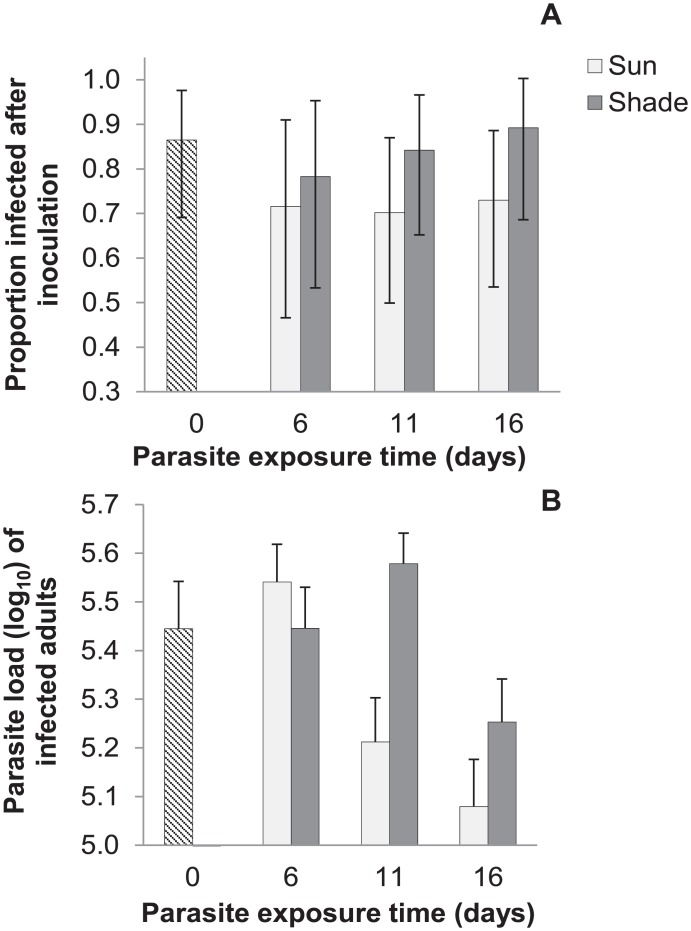
Experimental results on infectivity and pathogen load following spore exposure to sun or shade treatments for 0, 6, 11 or 16 days.(a) Proportion of monarchs infected following inoculation with spores on milkweed leaves exposed for 0 days (n = 27); 6 days, in either sun (n = 15) or shade conditions (n = 15); 11 days in sun (n = 23) or shade (n = 24); or 16 days in sun (n = 25) or shade (n = 19). Error bars show Jeffrey’s 95% confidence intervals for binary data. (b) Pathogen load (log-transformed) of monarchs infected with spores exposed for 0 days (n = 22); 6 days, in either sun (n = 10) or shade conditions (n = 11); 11 days in sun (n = 14) or shade (n = 18); or 16 days in sun (n = 17) or shade (n = 16). Error bars show standard error of the mean.